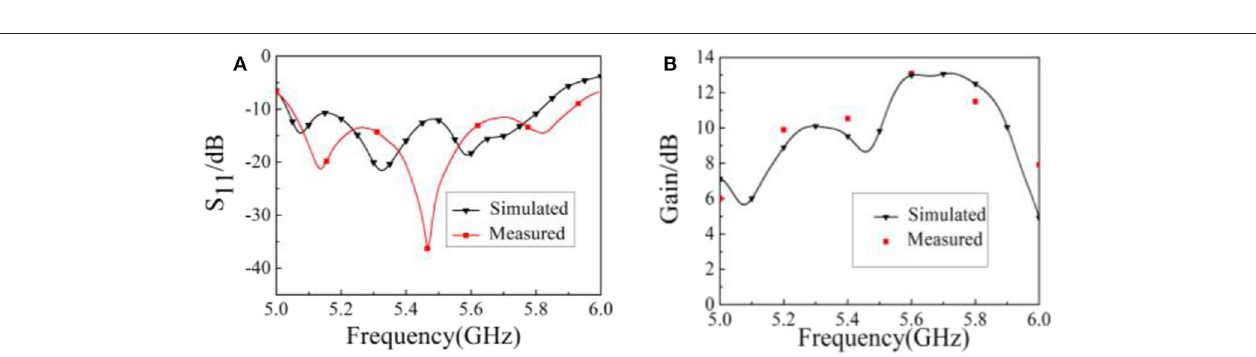
FIGURE 11 | The simulated and measured S 11 parameters and gains for type II antenna. (A) S 11 parameters, (B) gain.